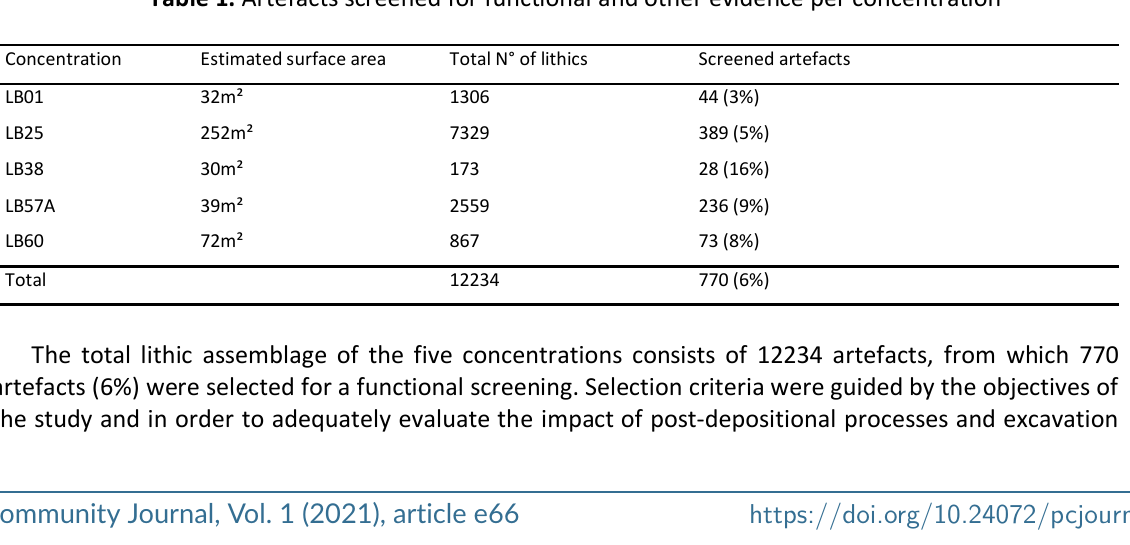
Table 1. Artefacts screened for functional and other evidence per